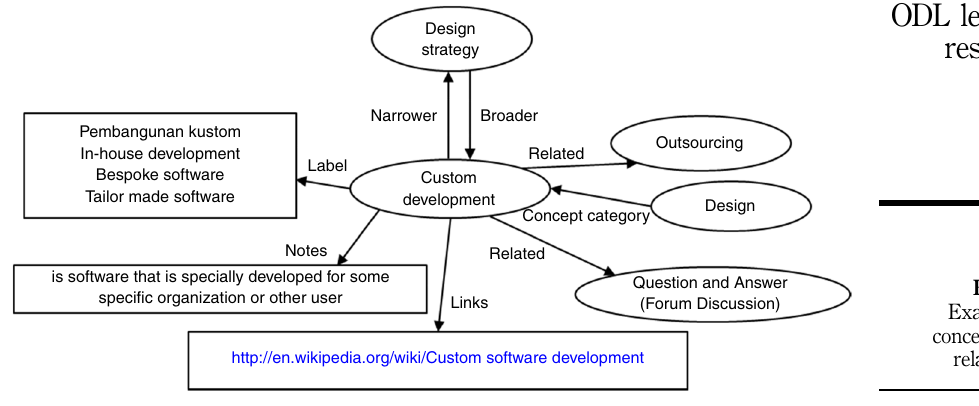
Figure 4. Example of a